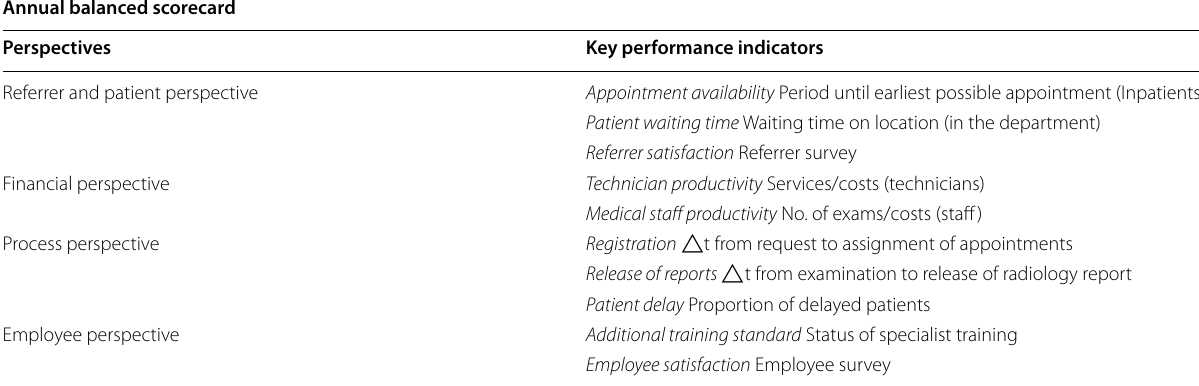
Table 2 Annual management scorecard for the radiology department Annual balanced